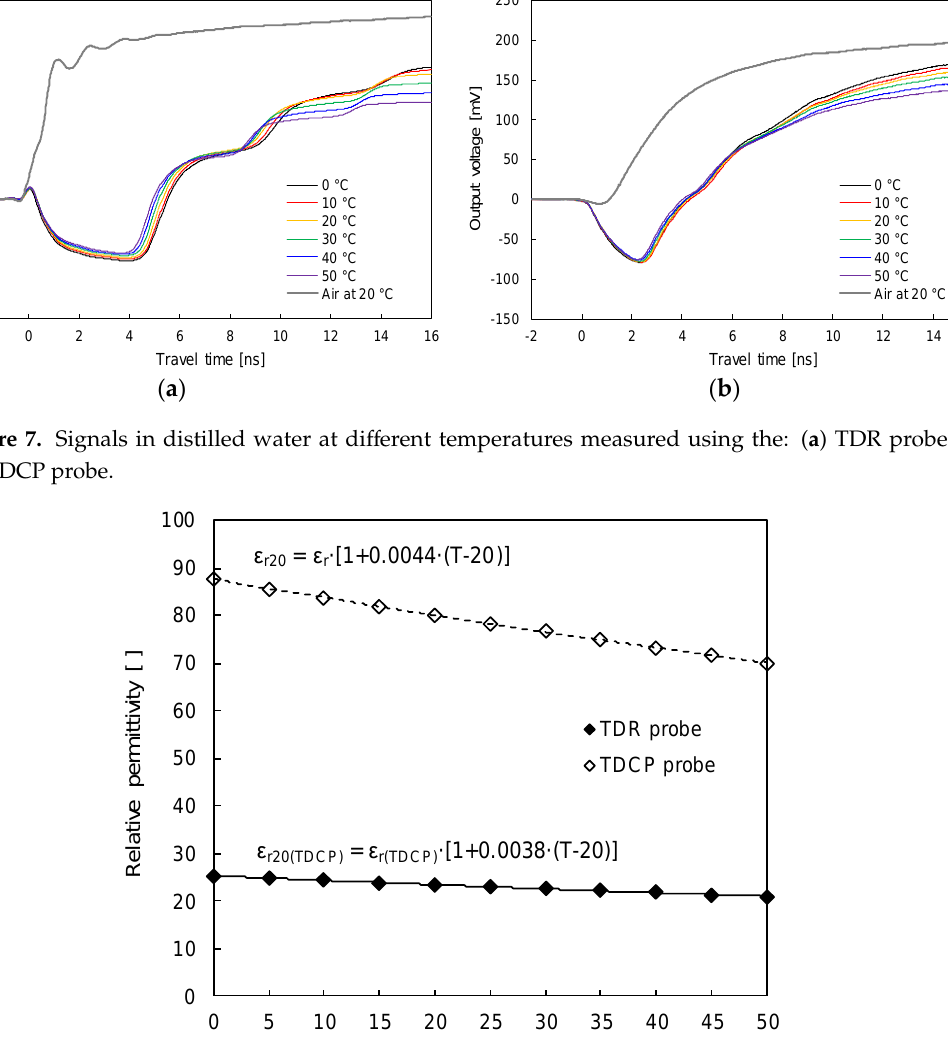
( b ) Figure 6. Calibration result: ( a ) Volumetric water content and the relative permittivity; ( b ) Relative permittivity measured using the TDR and TDCP probes. 4.2. Temperature Effect on Relative Permittivity In most cases, the subsurface is composed of a three-phase soil mixture such as air, soil particles, and water. Thus, the relative permittivity is greatly dependent on the volume fraction of water because the relative permittivity of the water is significantly greater than those of the other components. While relative permittivities of air and soil particles are hardly affected by temperature changes, the relative permittivity of water varies with regard to temperature change [35,38]. Accordingly, the temperature effect on the relative permittivity of the soil mixture is dependent on variations of the relative permittivity of water. Therefore, for an accurate evaluation of the volumetric water content, temperature effect on the relative permittivity of water should be investigated.